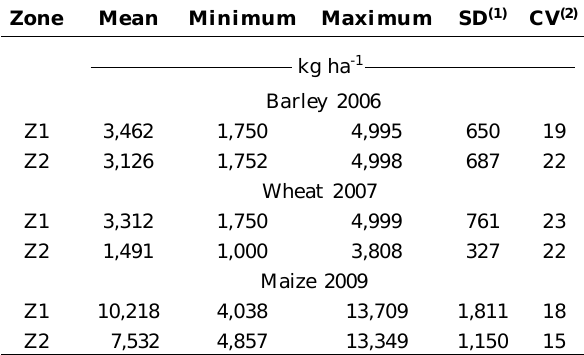
Table 2. Descriptive statistics of the data from the yield maps of barley (2006), wheat (2007) and maize (2009) in the zones of the plot selected for the Zone